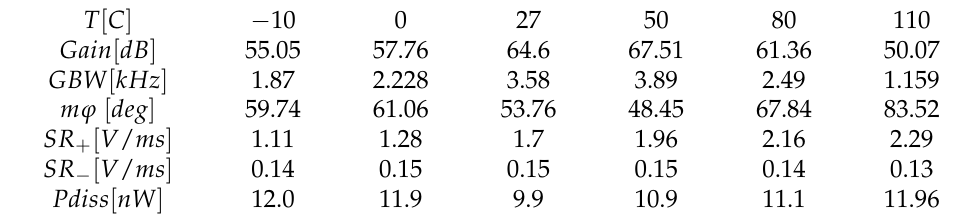
Table 4. Amplifier performance vs. temperature.